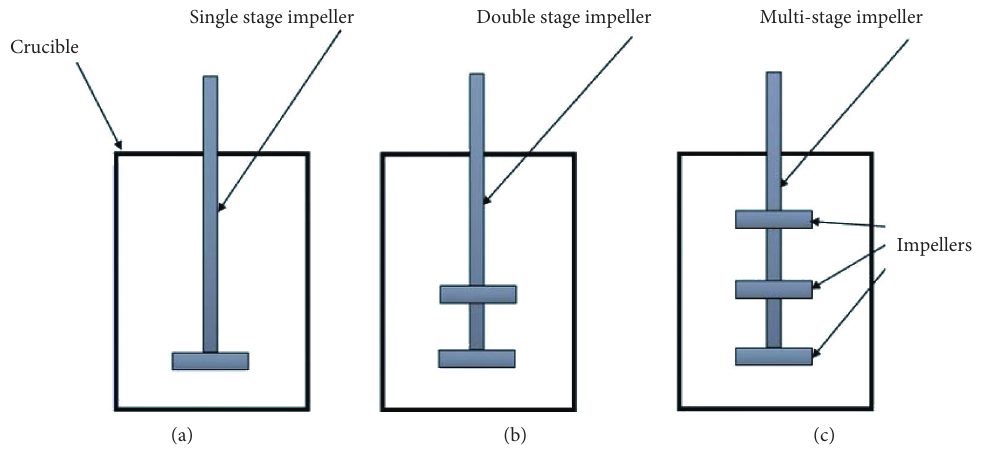
Figure 11: (a) Single stage. (b) Double stage. (c) Multistage [10].